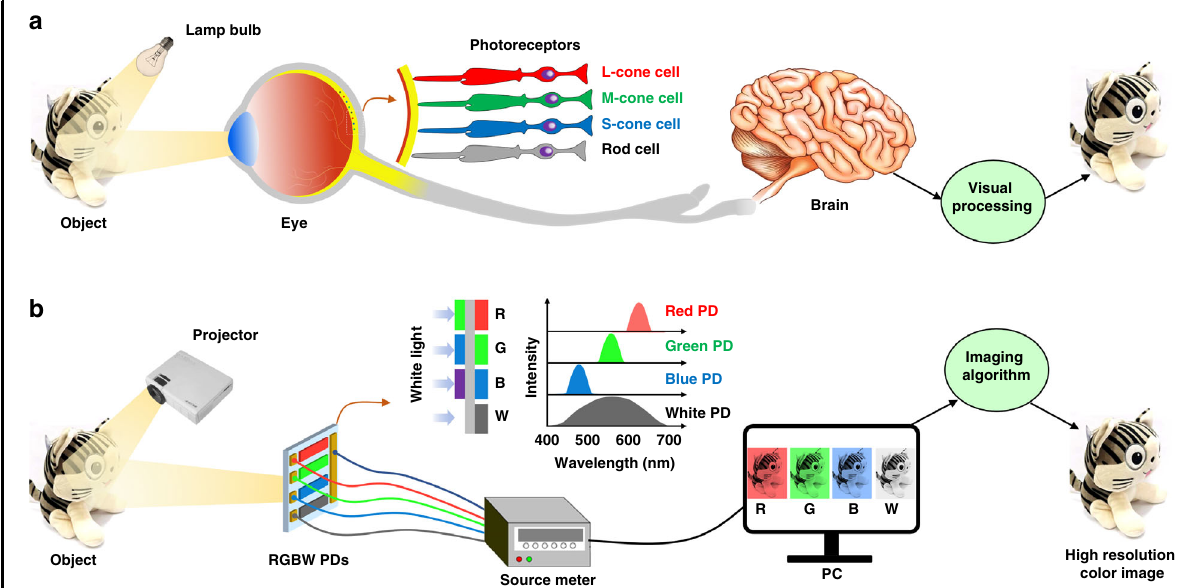
Fig. 1 Human visual cell inspired perovskite-based color camera. a Schematic of the human visual system with L-, M-, S-cone and rod cells. b The proposed imaging system with four types of perovskite PDs (RGBW PDs) acting as L, M, S-cone, and rod cells (one-to-one correspondences with a ) using a predesigned pattern illumination and image reconstruction